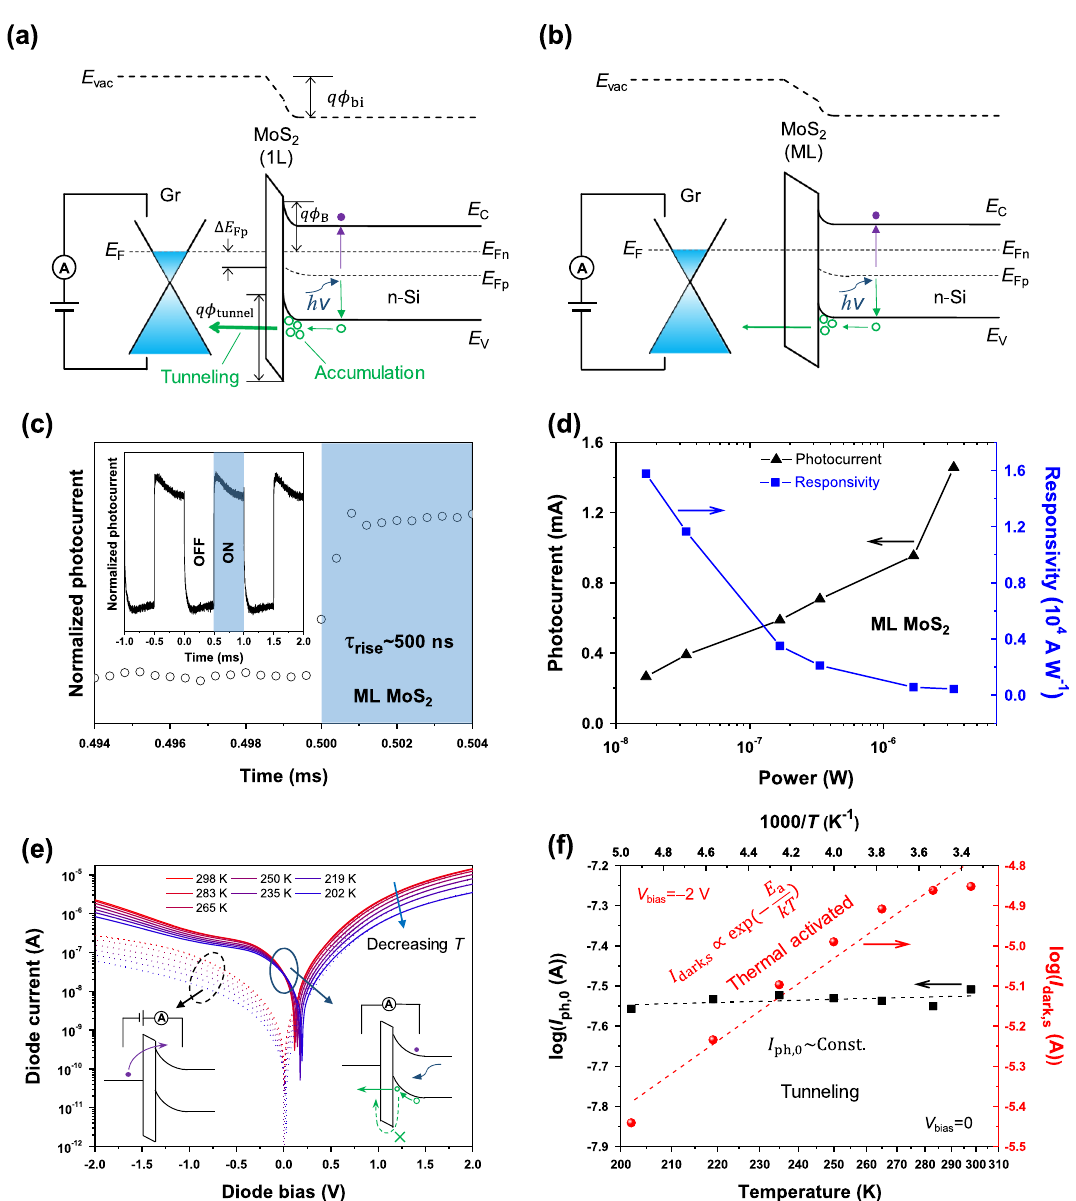
Fig. 4 Photoexcited carrier tunneling process in the hybrid graphene photoconductor. Energy-band diagram of the devices formed with monolayer (1 L) ( a ) and multilayer (ML) ( b ) MoS 2 fi lms. The number of the green circles indicates the relative population of accumulated carriers. The accumulated carriers can tunnel to graphene through the MoS 2 layer, as shown by the green lines . The sizes of the green lines indicate the relative tunneling probability. A thicker tunneling barrier results in a smaller tunneling probability. c Transient characteristics of the hybrid graphene photoconductor with ML MoS 2 under 635 nm illumination, showing a rising time of ~500 ns. Inset is the switching performance over three periods of square-wave modulation. d Photocurrent and responsivity as functions of the illumination power of the device with ML MoS 2 . e Current vs. bias curves of the device operating in diode mode in the dark ( dashed curves ) and under 635 nm (3.35 μ W) illumination ( solid curves ) at various temperatures. Insets schematically show the carrier transport in dark (reverse bias) and under illumination (zero bias), respectively. f Zero-bias photocurrent ( I ph,0 ) and reverse saturation dark current at − 2 V ( I dark,s ) as functions of temperature (Arrhenius plot) extracted from ( e ). The dashed lines show the linear fi